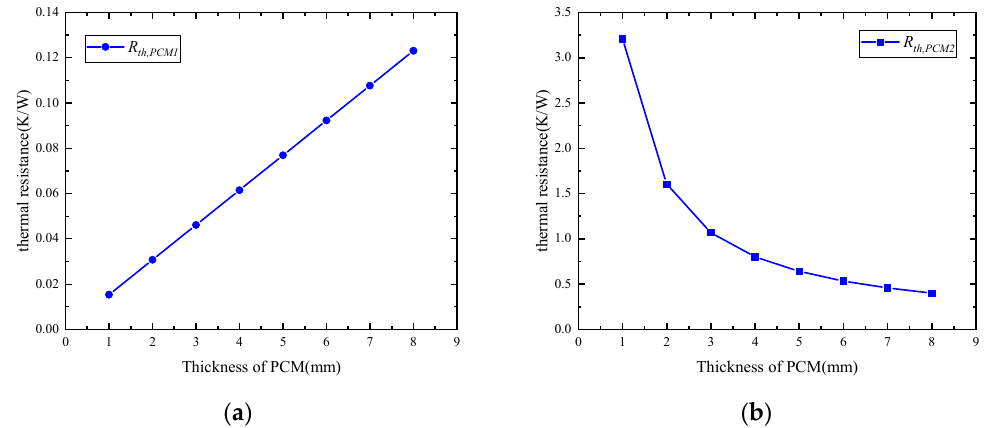
Figure 12. The changes in thermal resistance with different thicknesses of PCM. ( a ) Comparison of the R th,PCM1 with different thicknesses of PCM; ( b ) Comparison of the R th,PCM2 with different thicknesses of PCM.